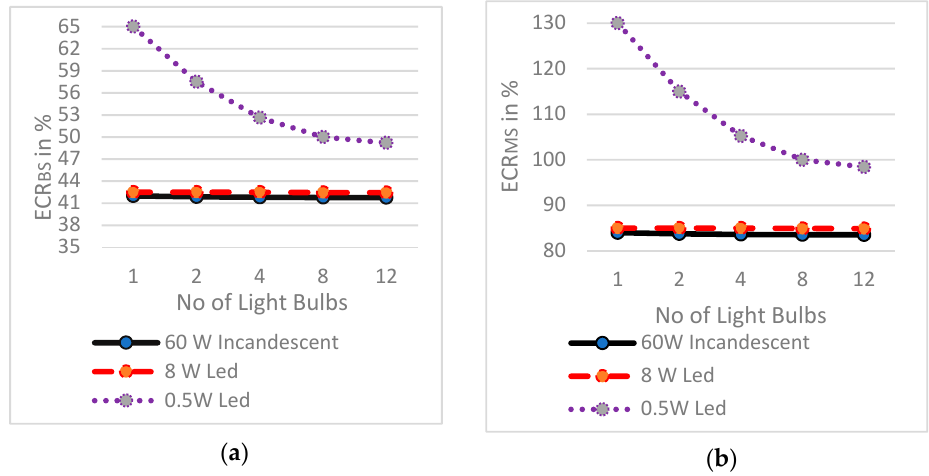
Figure 9. Energy consumption ratio vs. number of light bulbs for: ( a ) Comparison of ECR BS of 60 W incandescent Light, 8 W LED and 0.5 W LED light bulbs and ( b ) comparison of ECR MS of 60 W incandescent Light, 8 W LED and 0.5 W LED light bulbs.